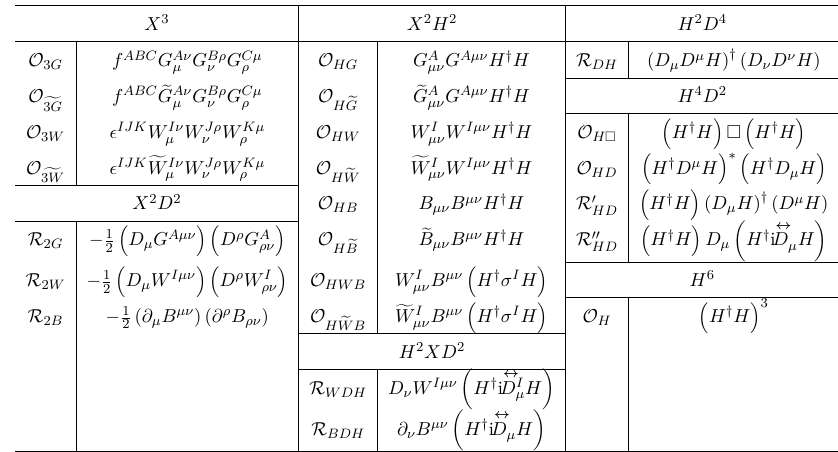
Table 3 . Bosonic operators in the Green’s basis in the SMEFT.